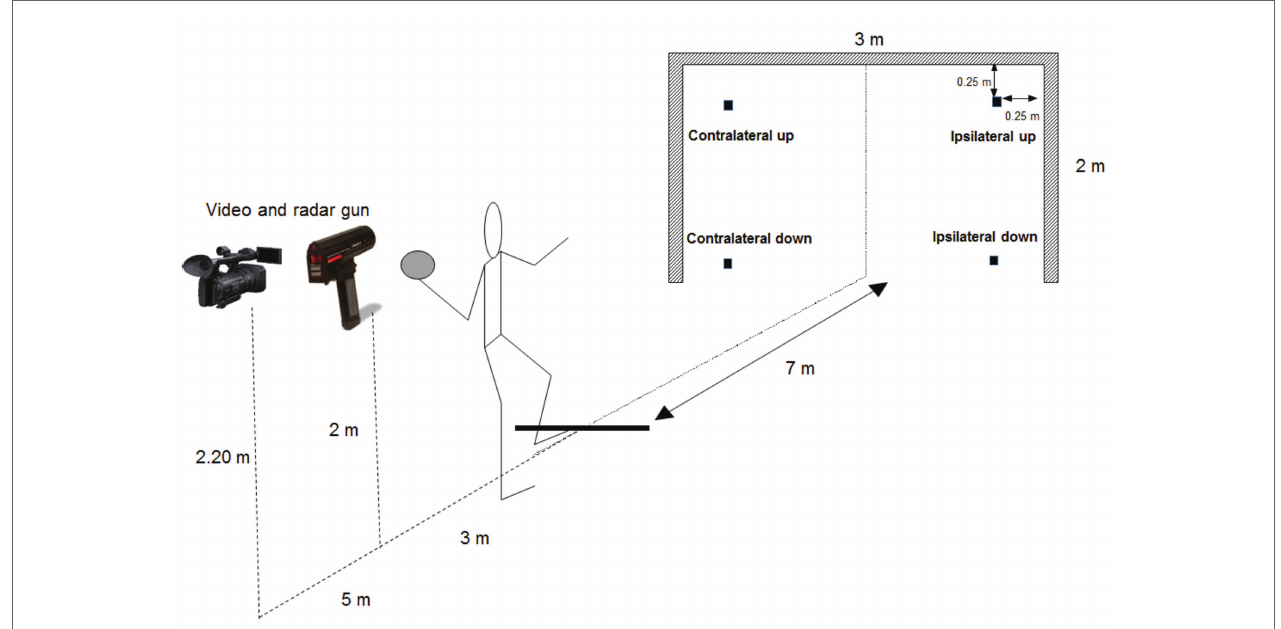
FIGURE 1 | Experimental setup with the different targets and distances.